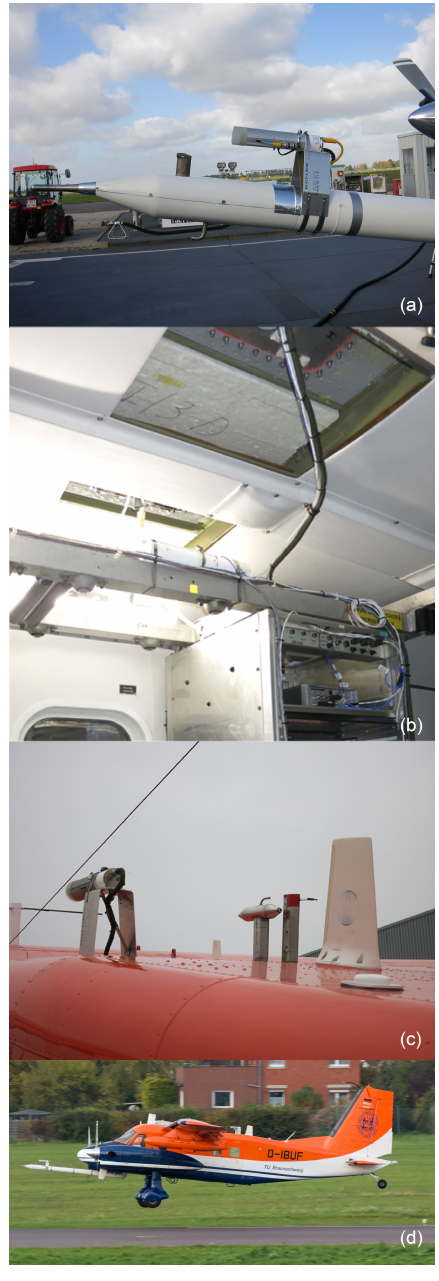
Figure 1. The three LI-COR sensors integrated into the Do128 dur- ing a humidity intercomparison flight: (a) LI7500A on the nose boom (Li1), (b) LI7200 in the cabin with an inlet near the LI-COR sensor on the roof (Li2), (c) LI7500 on the roof (Li3) and (d) the Do128 equipped with additional sensors during the flight (last photo courtesy of Uwe